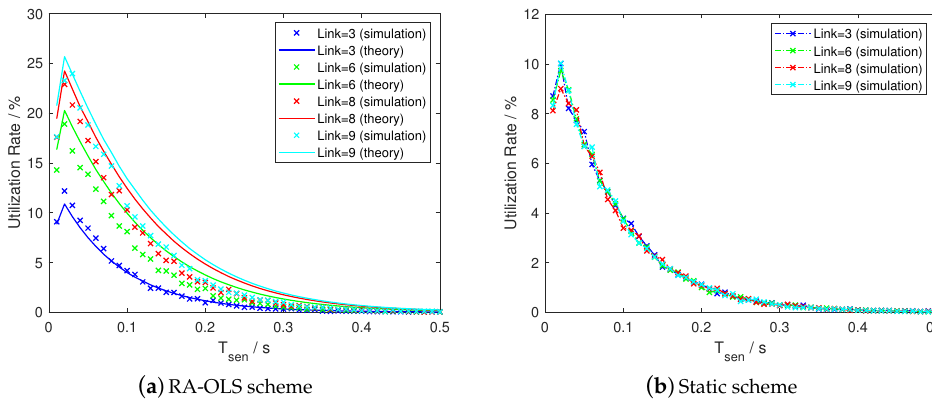
Figure 14. Spectrum utilization rate by differing link number with K = 3 UAVs, SNR = 1 dB, and F s = 400